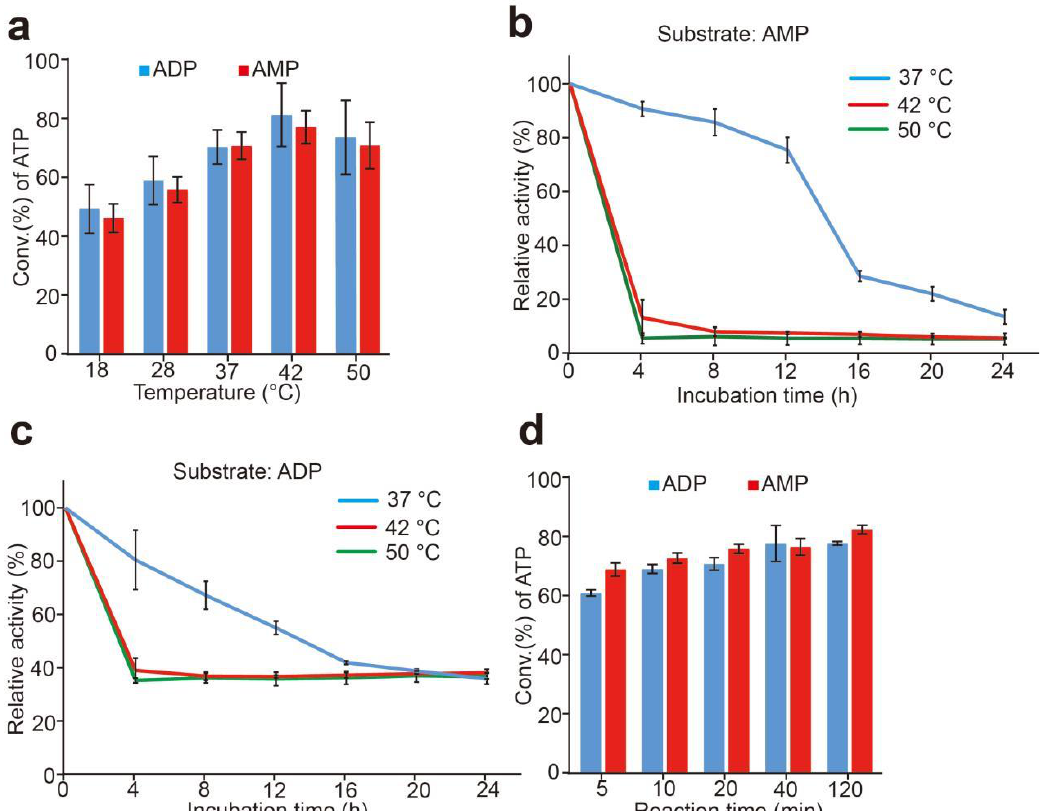
Figure 8. Effect of temperature on ATP synthesis and thermostability of sfGFP-PAP-Pb. ( a ): Effect of temperature on ATP production from ADP or AMP. Productivity was assayed at 18 – 50 °C. ( b , c ): Temperature dependency of the sfGFP-PAP-Pb intact cells using AMP ( b ) or ADP ( c ). The enzyme solution was incubated at 37 °C, 42 °C, and 50 °C for different times, and residual ATP-synthesizing activity was measured to determine thermostability. ( d ): Effect of reaction time on ATP production. Productivity was assayed at 37 °C for 5 – 120 min. The reaction mixture contains 20 mM poly(P), 4 mM ADP or AMP, 30 mM Mg 2+ and 50 mM Tris-HCl (pH 8.5), moderate cells were added. Results are means ± SD of three parallel replicates.